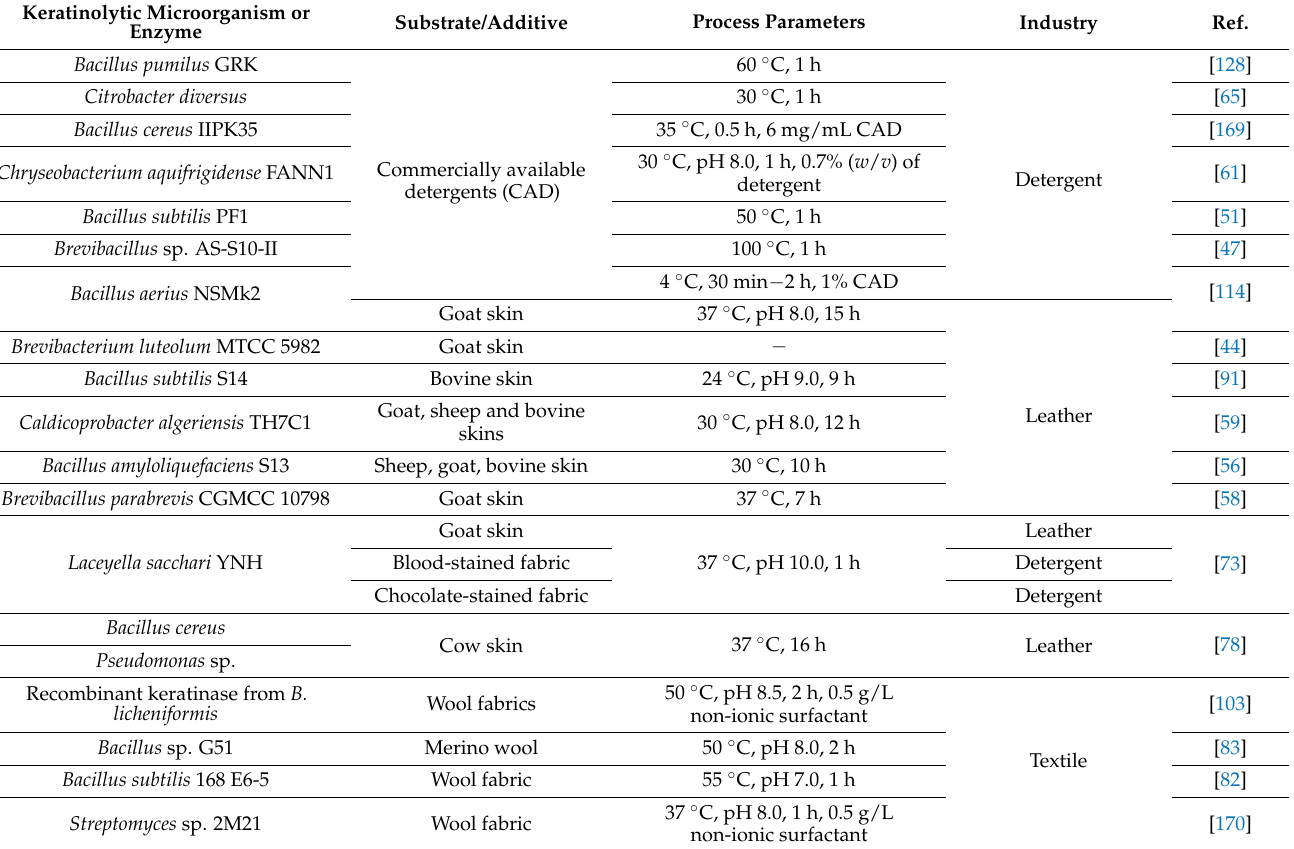
Process Parameters Industry Ref.